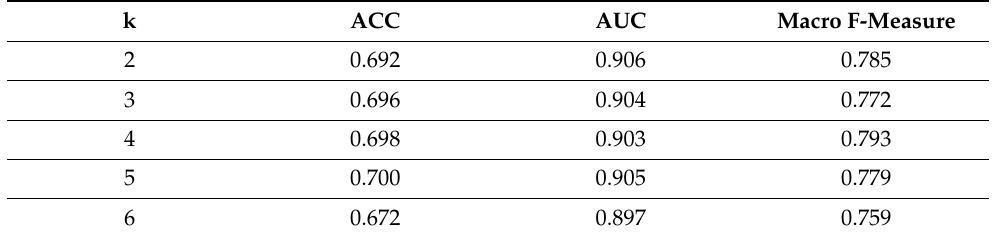
Table 4. Performance of feature PSTNPSSMC combined with various values of parameter k in the